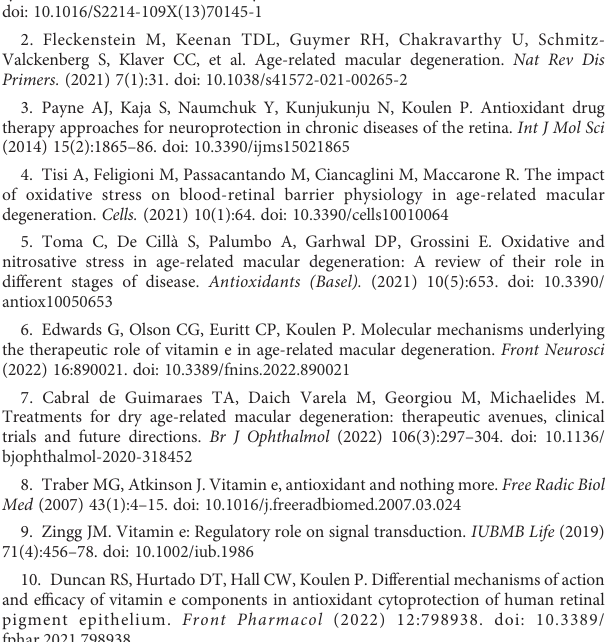
SUPPLEMENTARY FIGURE 1 Tocopherol-tBHP Treatment Paradigm for hTERT RPE Cells. hTERT RPE cells were exposed for to either 100 m M a T, 100 m M g T or equivalent volume of DMSOcontrolfor24hours.Afterthe24-hourexposure,cellswererinsedand